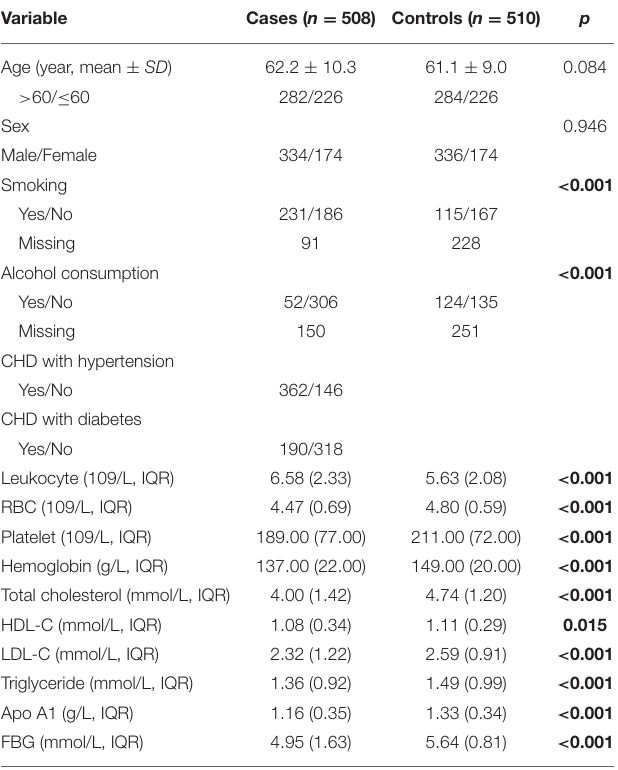
TABLE 1 | Characteristics of patients with CHD and controls. Variable